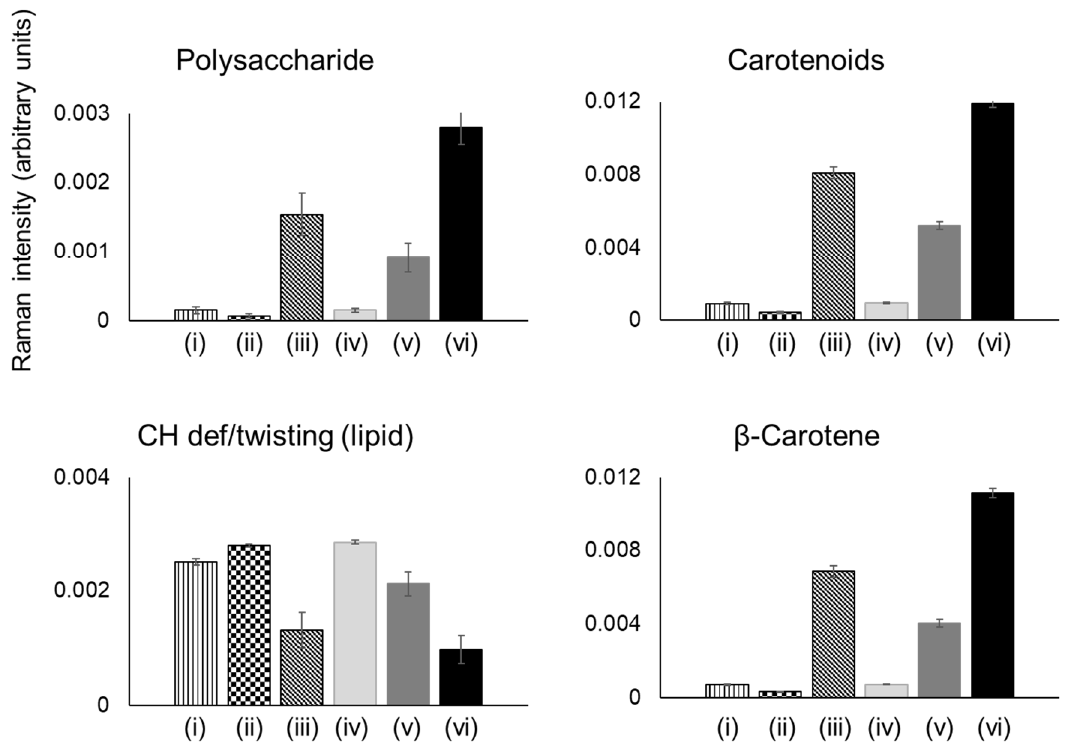
Figure 5. Intensity changes of polysaccharide, carotenoids, lipids, and β -carotene specific peaks in the Raman spectra of fermented single strength / concentrated juices (fermented by L. gasseri strains) comparing to unfermented juices: (i) Unfermented single strength juice, (ii) Single strength juice fermented by DSM 20604, (iii) Single strength juice fermented by DSM 20077, (iv) Unfermented concentrated juice, (v) Concentrated juice fermented by DSM 20604, and (vi) Concentrated juice fermented by DSM 20077.